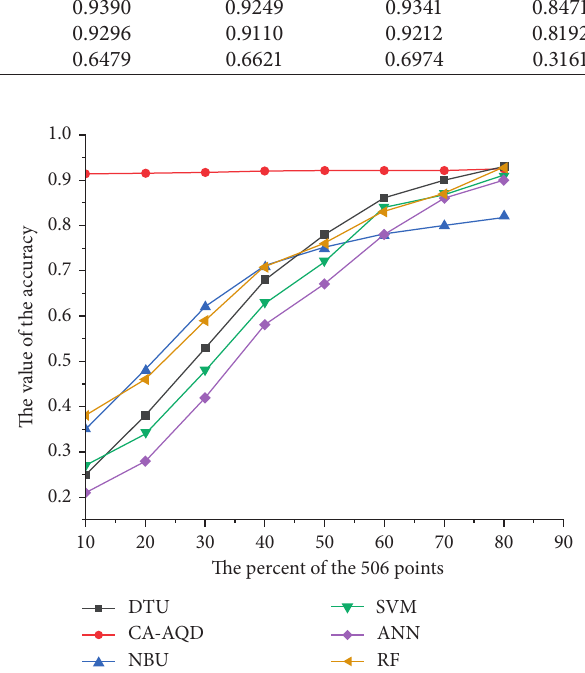
Figure 11: Comparison of the performance accuracy among CA- AQD, DTU, NBU, SVN, ANN, and RF